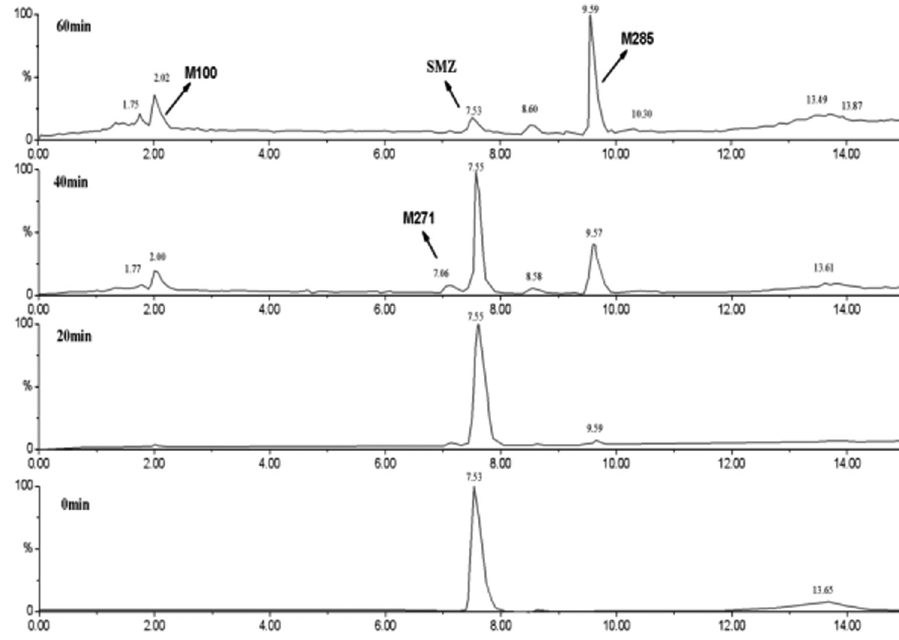
Figure 6: Chromatogram of SMZ degradation at di ff erent reaction times.